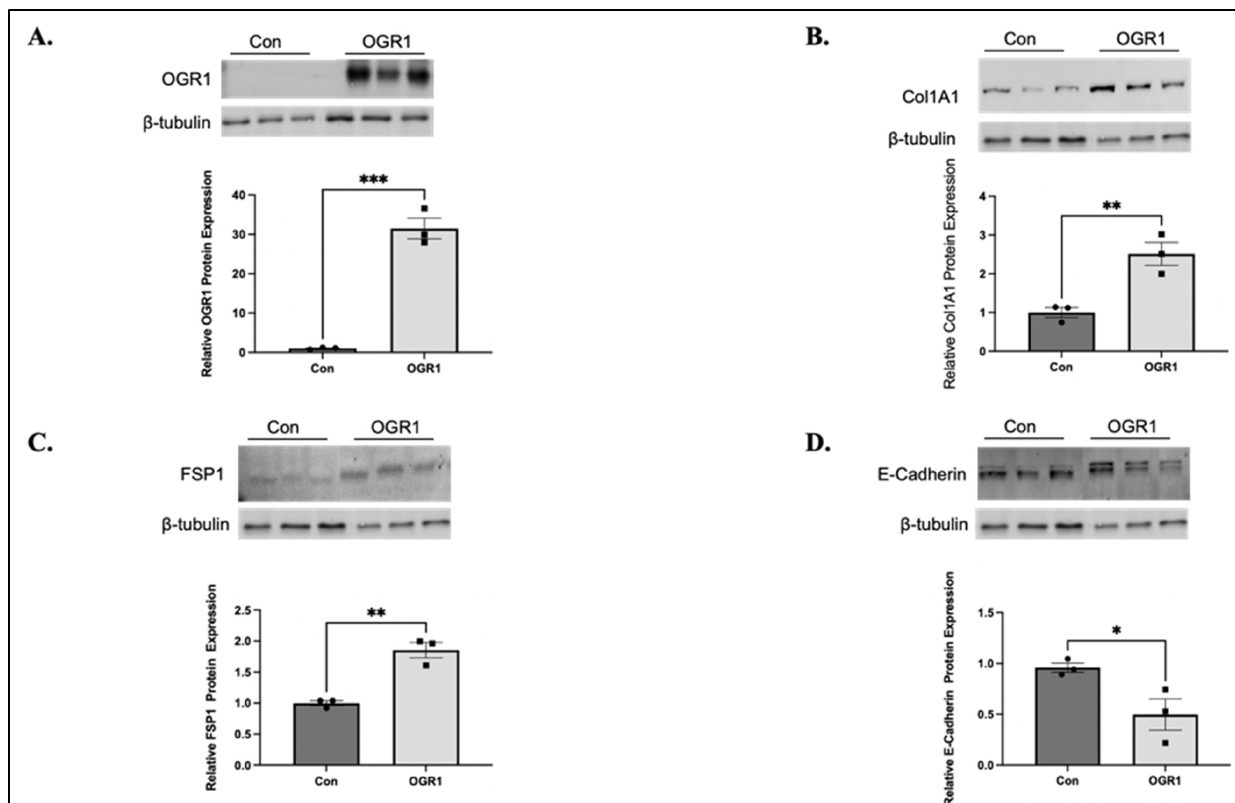
Figure 6. Overexpression of OGR1 in 16-HBE cells causes EMT. We then examined the effects of OGR1 overexpression in 16-HBE cells under basal conditions. OGR1 was successfully transfected into 16-HBE cells ( A , *** p = 0.0003). We then assessed for changes in protein expression that are consistent with EMT. OGR1 overexpression led to significant increases in collagen 1A1 ( B , ** p = 0.0092), fibroblast specific protein 1 (FSP1) ( C , ** p = 0.0028), and decreased E-cadherin expression ( D , * p = 0.0440). Data represent mean expression ± SEM.